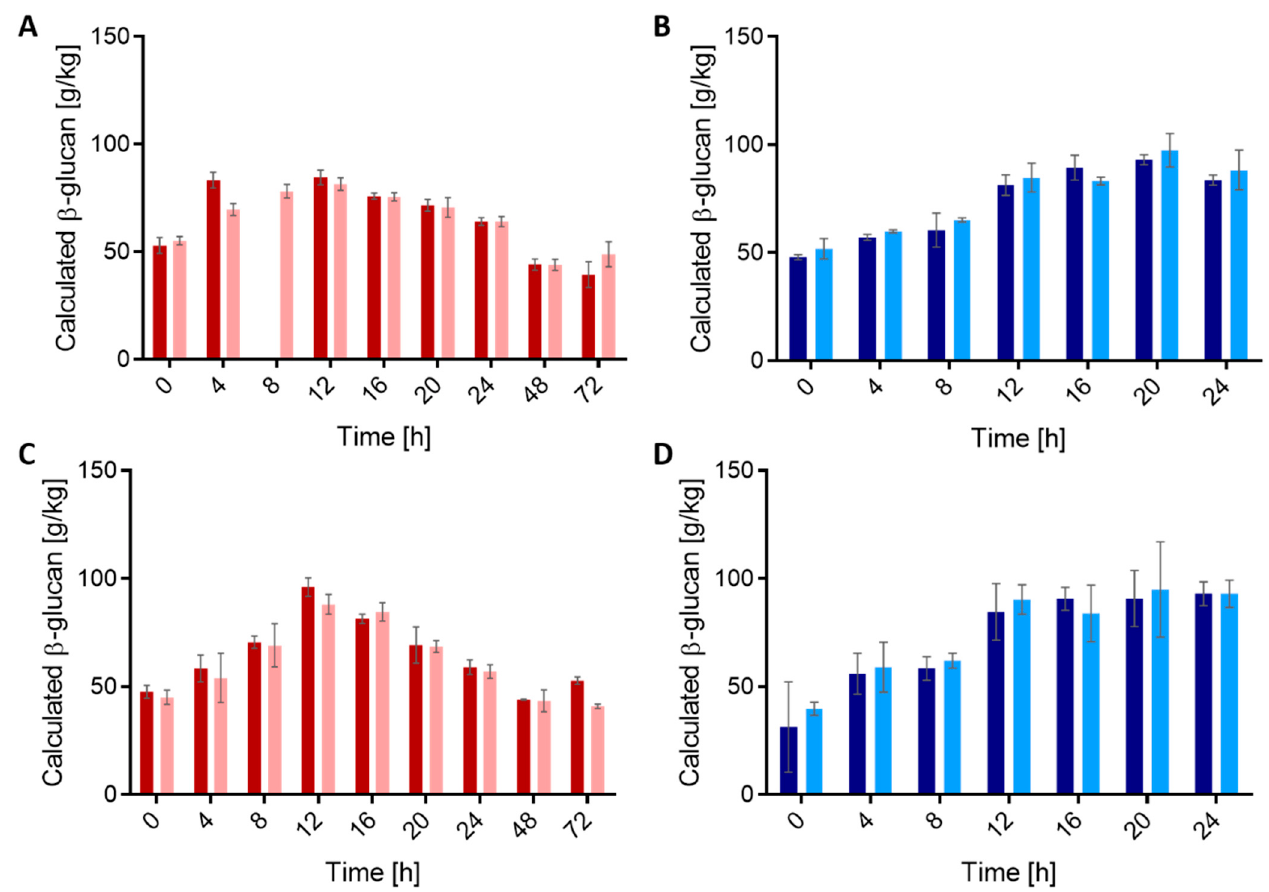
Figure 1. Calculated β -glucan concentration of the total glucose content in wheat and rye sourdoughs measured by HPLC. ( A ) L. brevis TMW 1.2112 ( (cid:122) ) and L. brevis TMW 1.2320 ( (cid:122) ) in wheat sourdough, ( B ) P. claussenii TMW 2.340 ( (cid:122) ) and P. claussenii TMW 2.2123 ( (cid:122) ) in wheat sourdough, ( C ) L. brevis TMW 1.2112 and L. brevis TMW 1.2320 in rye sourdough, and ( D ) P. claussenii TMW 2.340 and P. claussenii TMW 2.2123 in rye sourdough. The calculated β -glucan amounts were analyzed from biological triplicates with standard deviations.